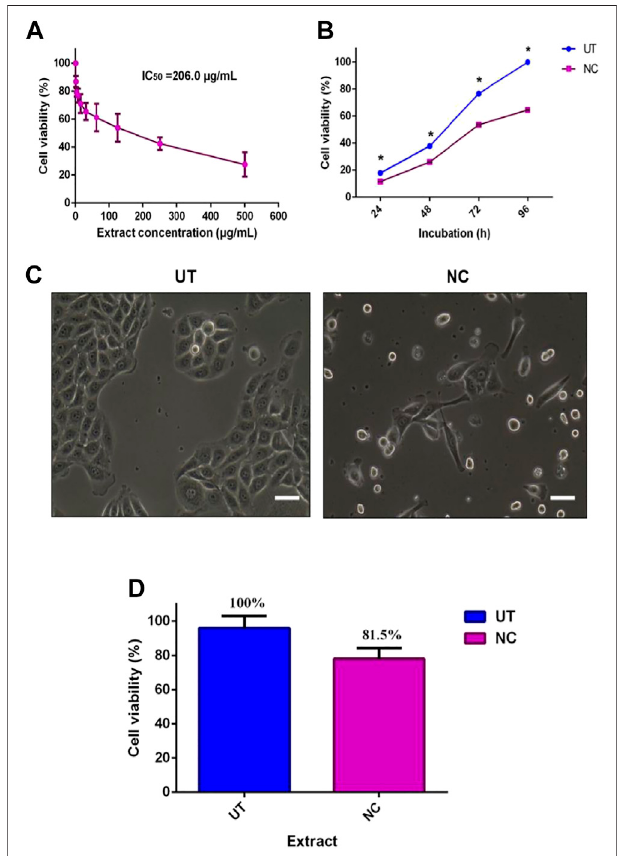
FIGURE 1 | Effect of NC leaves ’ 80% ethanol extract on MCF-7 cell viability. (A) The median concentration of MCF-7 treated with NC leaves ’ 80% ethanol extract for 72 h. (B) Antiproliferative effect of NC leaves ’ 80% ethanol extract at 24, 28, 72, and 96 h with untreated cells (UT) as controls. (C) Image of MCF-7 cells with NC leaves ’ 80% ethanol extract treated and untreated at 72 h. (D) Cytotoxic effect of NC leaves ’ 80% ethanol extract median concentration on normal human dermal fi broblast (HDF) cells at 72 h incubation. The results presented as mean ± SD ( n (cid:2) 3) (bar graph (cid:2) 25 μ m). * indicates p <